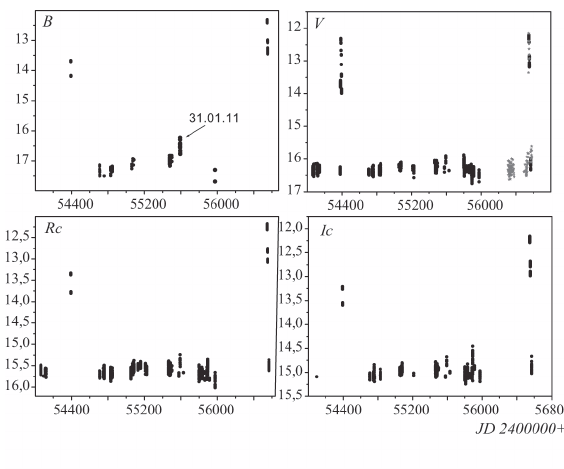
Figure 1: The BVR C I C LCs of HS 0218+3229 in 2006–2013. The AAVSO data are marked by grey cir- cles.